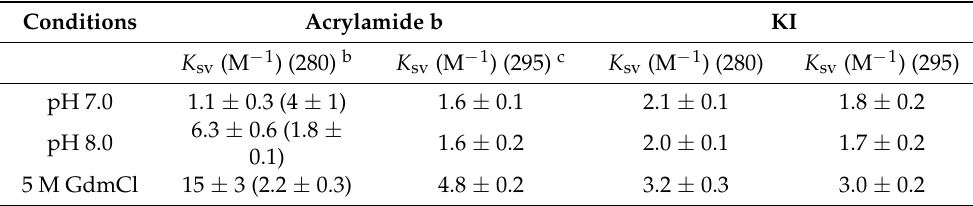
Table 1. Quenching parameters in KI and acrylamide of bsHprK/P a .